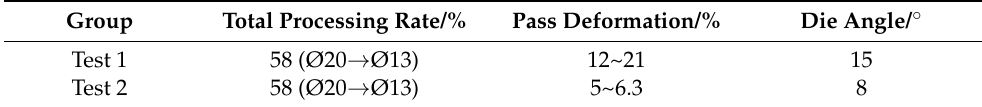
Table 5. Main drawing parameters for the two experimental groups. Group Total Processing Rate/% Pass